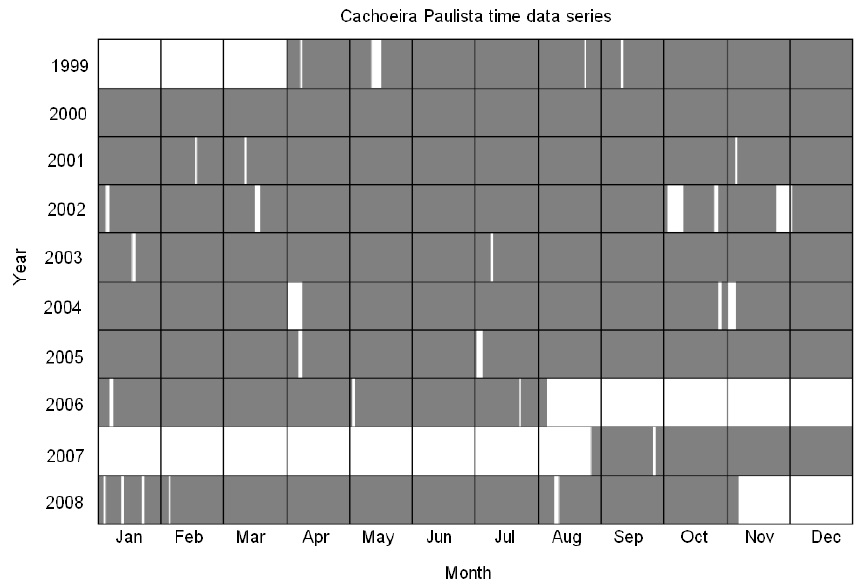
Figure 3: Fig. 2. The same as Fig. 1 but for the meteor radar at